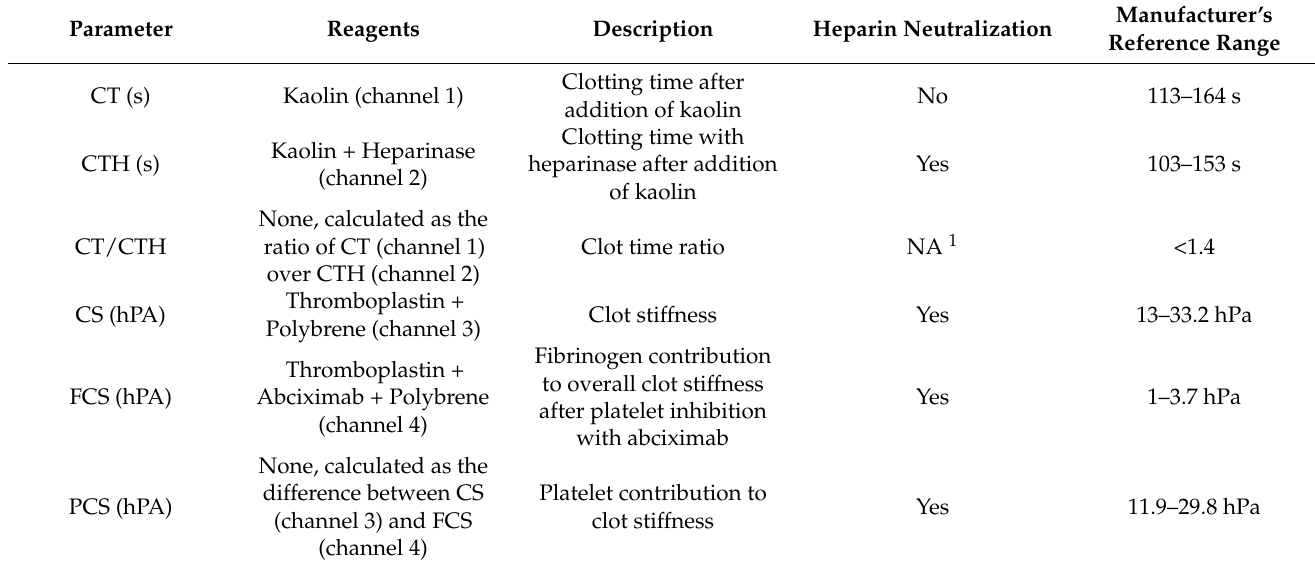
Table A5. Quantra®QPlus cartridge and parameters.